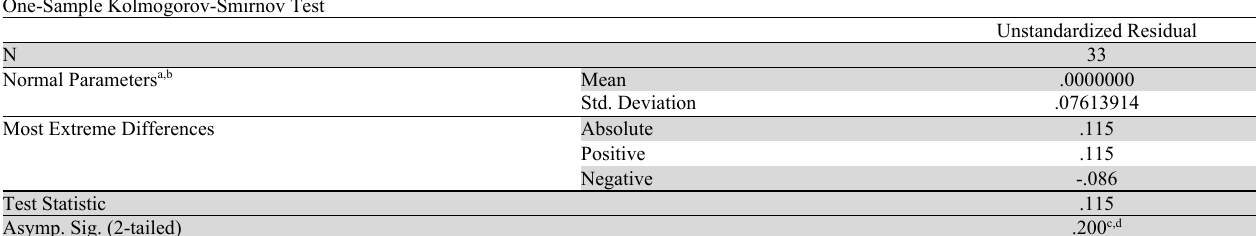
Normality test One-Sample Kolmogorov-Smirnov Test